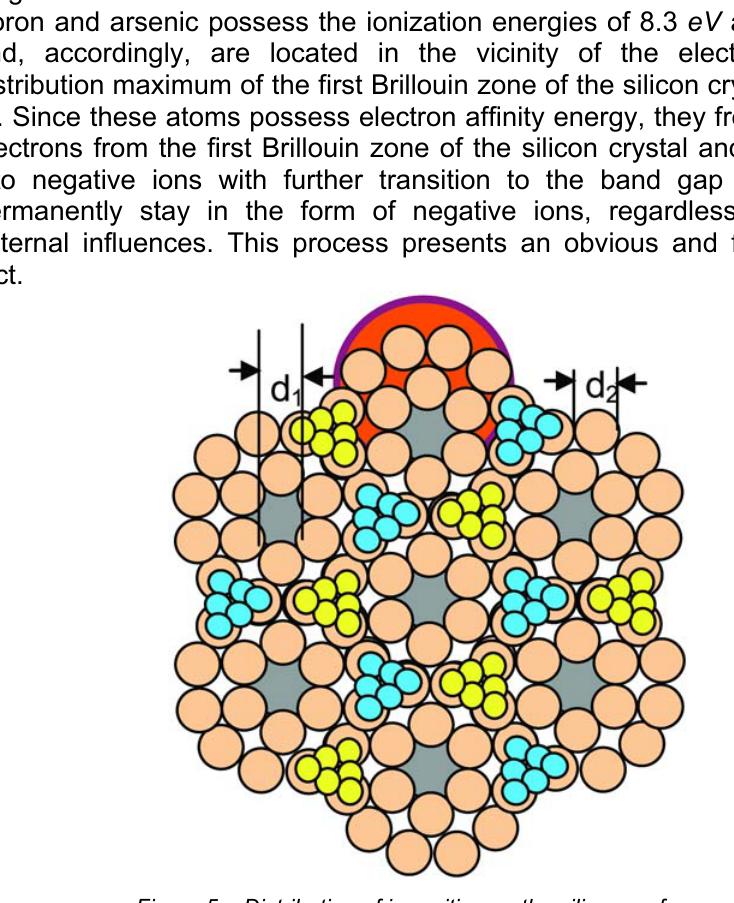
Figure 5 – Distribution of impurities on the silicon surface Рис . 5 – Расположение примесей на поверхности кремния Слика 5 – Дистрибуција примеса на површини